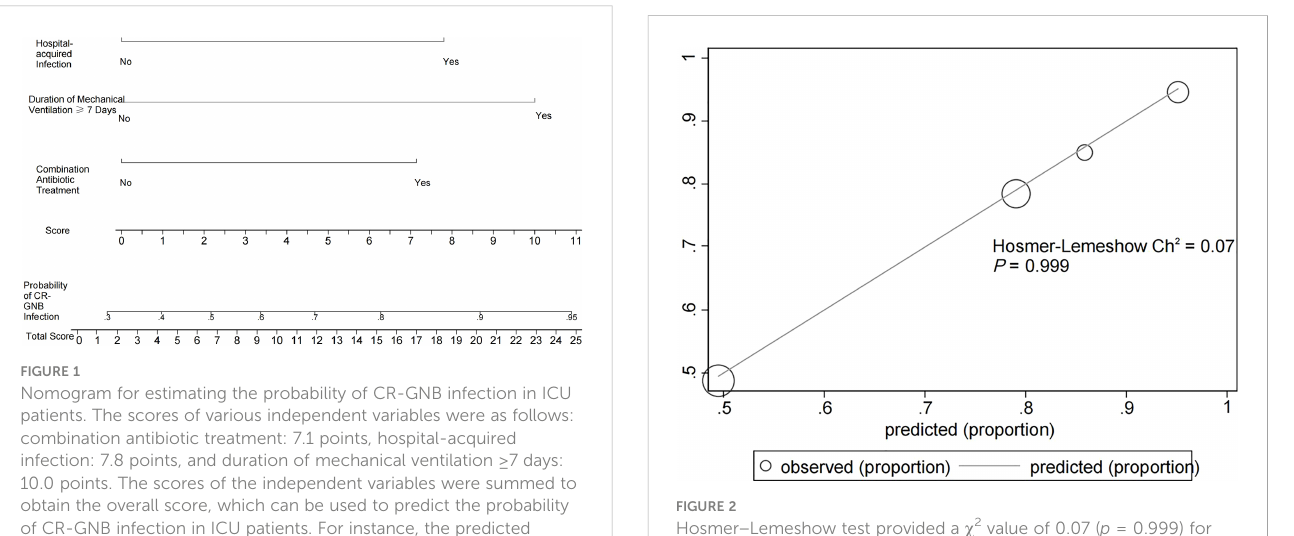
ICU patients. The plotted nomogram indicated that the predicted